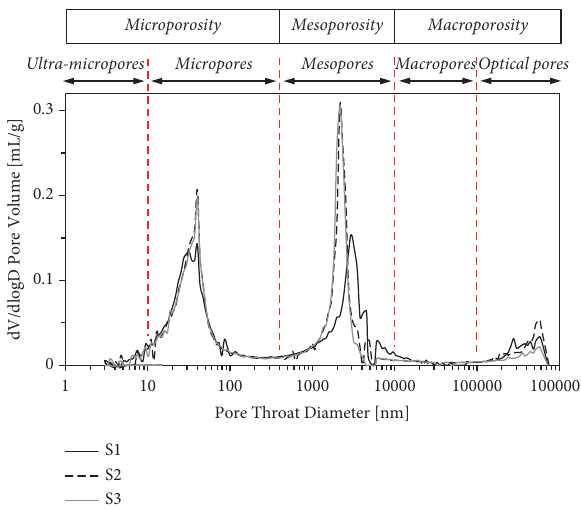
Figure 8: Pore throat diameter distribution for the samples prepared by the three protocols. Table 4: Porosity and pore throat diameters from the MIP tests for the samples prepared by the three protocols. Sample